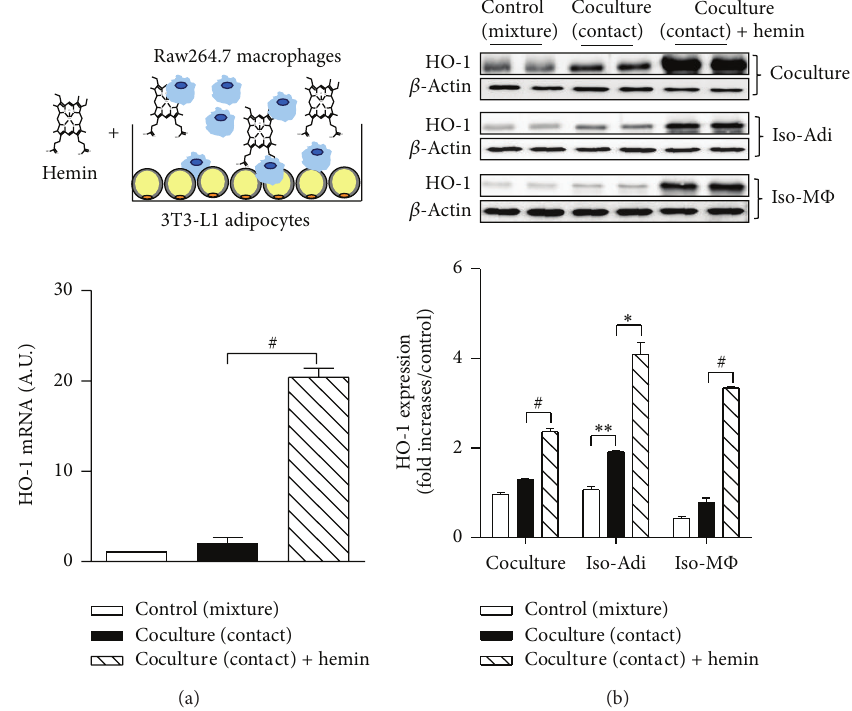
Figure 1: HO-1 induction in adipocyte and macrophage cocultures. Coculture of 3T3-L1 adipocytes and Raw264.7 macrophages were cocultured in direct contact in a ratio 1: 1 for 24 h in the presence or absence of hemin (10 𝜇 M). As a control, adipocytes and macrophages were also cultured separately, with cell numbers per well equal to those in the contact system and mixed after harvesting. (a) Total RNAs were isolated and the level of HO-1 transcripts was analyzed by qRT-PCR. 36B4 was used as a control gene. A.U.: arbitrary units. (b) After 24 h of coculture, the cell types were separated using CD11b microbeads. Levels of HO-1 protein expression were measured in coculture, isolated adipocytes (Iso-Adi), and macrophages (Iso-M B ) by western blotting; 𝛽 -actin was used as a control. The experiment was isolated in duplicate. Results are means ± SEM. ∗ 𝑃 < 0.05 , ∗∗ 𝑃 < 0.01 , and # 𝑃 < 0.005